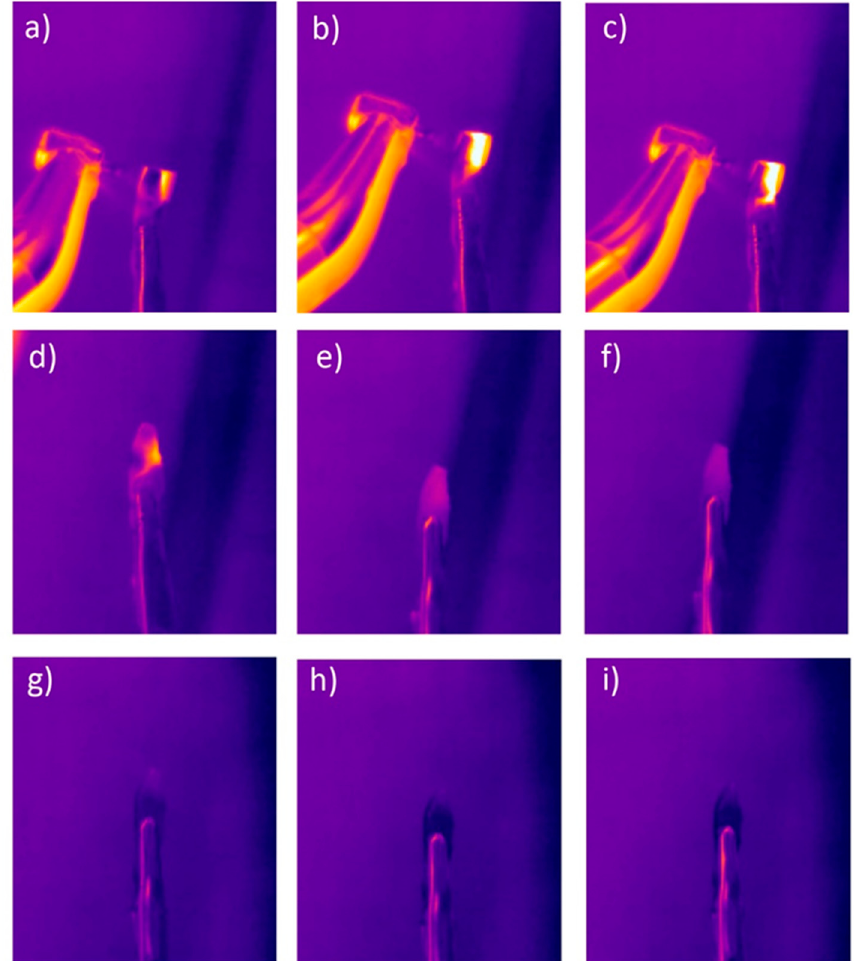
Figure 6. Exemplary thermograms of incisors subjected to polishing with water cooling. ( a ) 10 s of polishing; ( b ) 20 s of polishing; ( c ) 60 s of polishing; ( d ) immediately after finishing; ( e ) +5 s after finishing; ( f ) +10 s after finishing; ( g ) +20 s after finishing; ( h ) +50 s after finishing; ( i ) +70 s after finishing.